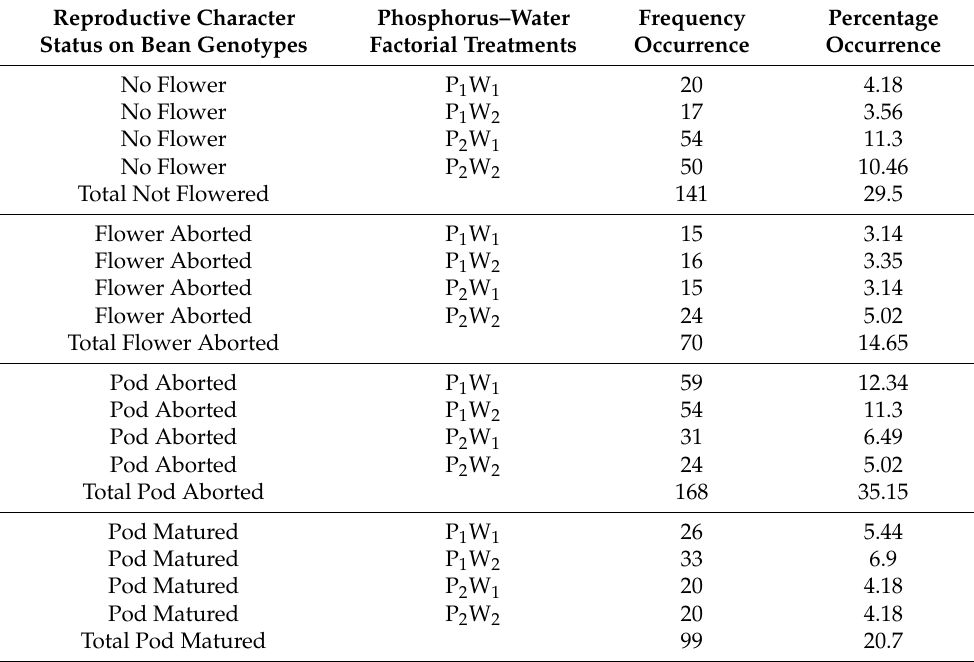
Table 5. Flowering and pod formation characteristics of 478 drought-tolerant common bean plants in factorial experiments with phosphorus–water treatments under sheltered-roof screen-house conditions. Reproductive Character Status on Bean Genotypes